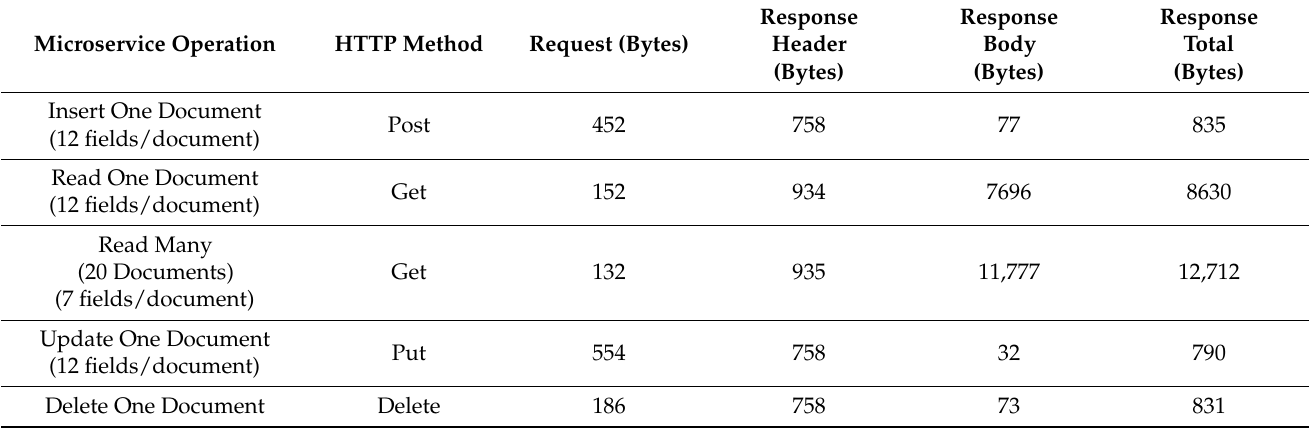
Table A7. Characteristics of the requests and responses of the system core